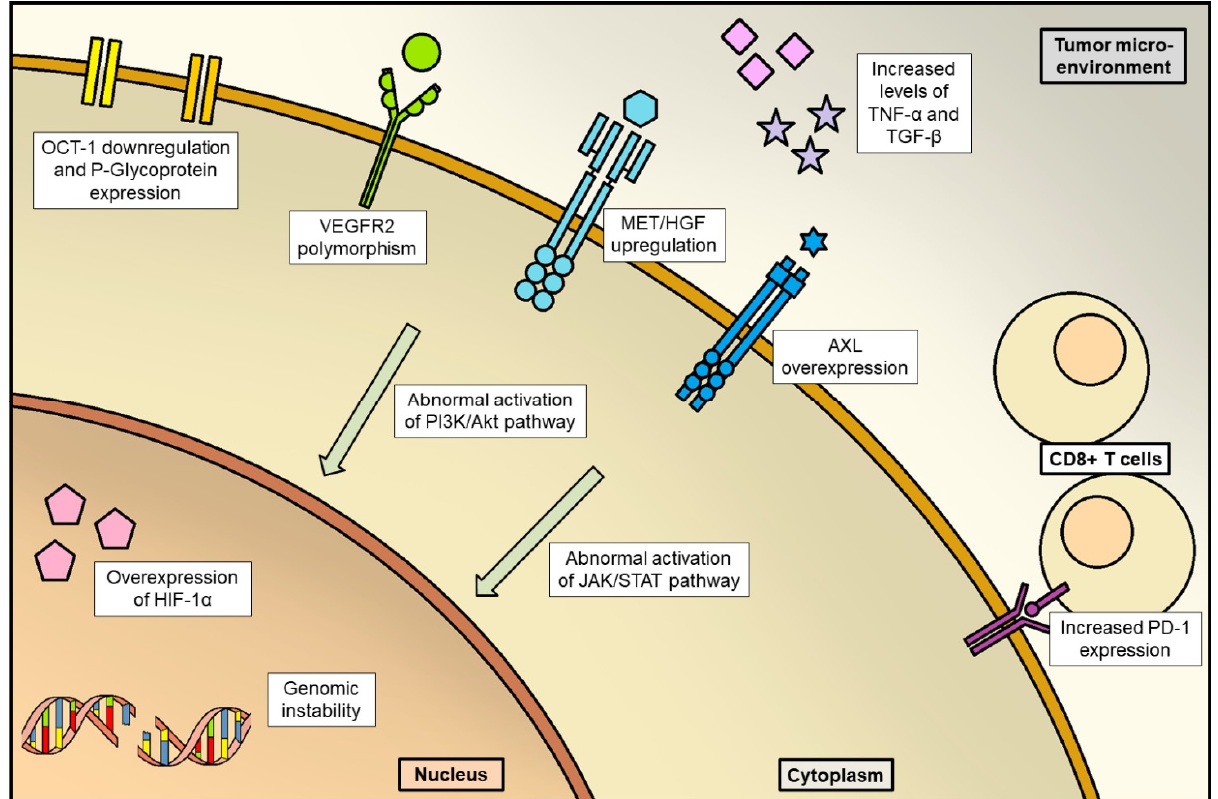
Figure 1. Main mechanisms of anti-angiogenic drug resistance in HCC . In this figure, the main mechanisms of resistance are summarized, represented at three levels: intranuclear, intracytoplasmic and tumor